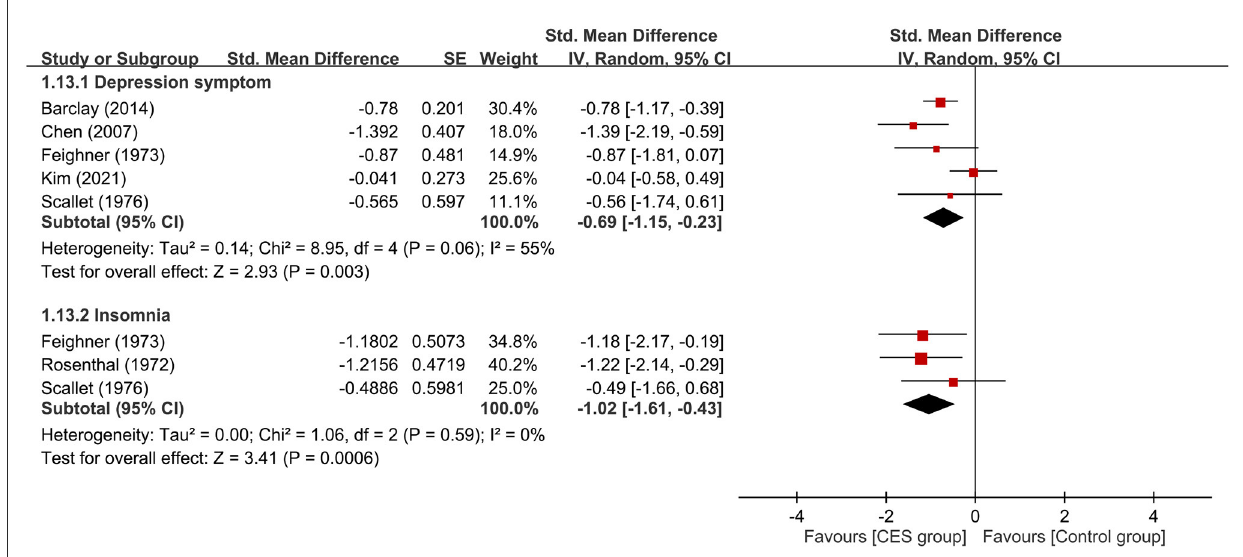
FIGURE8 Forest plots comparing the severity of depression symptoms and insomnia between CES and control groups. CES, cranial electrotherapy stimulation; Std, standardized; CI, confidence interval; SE, standard